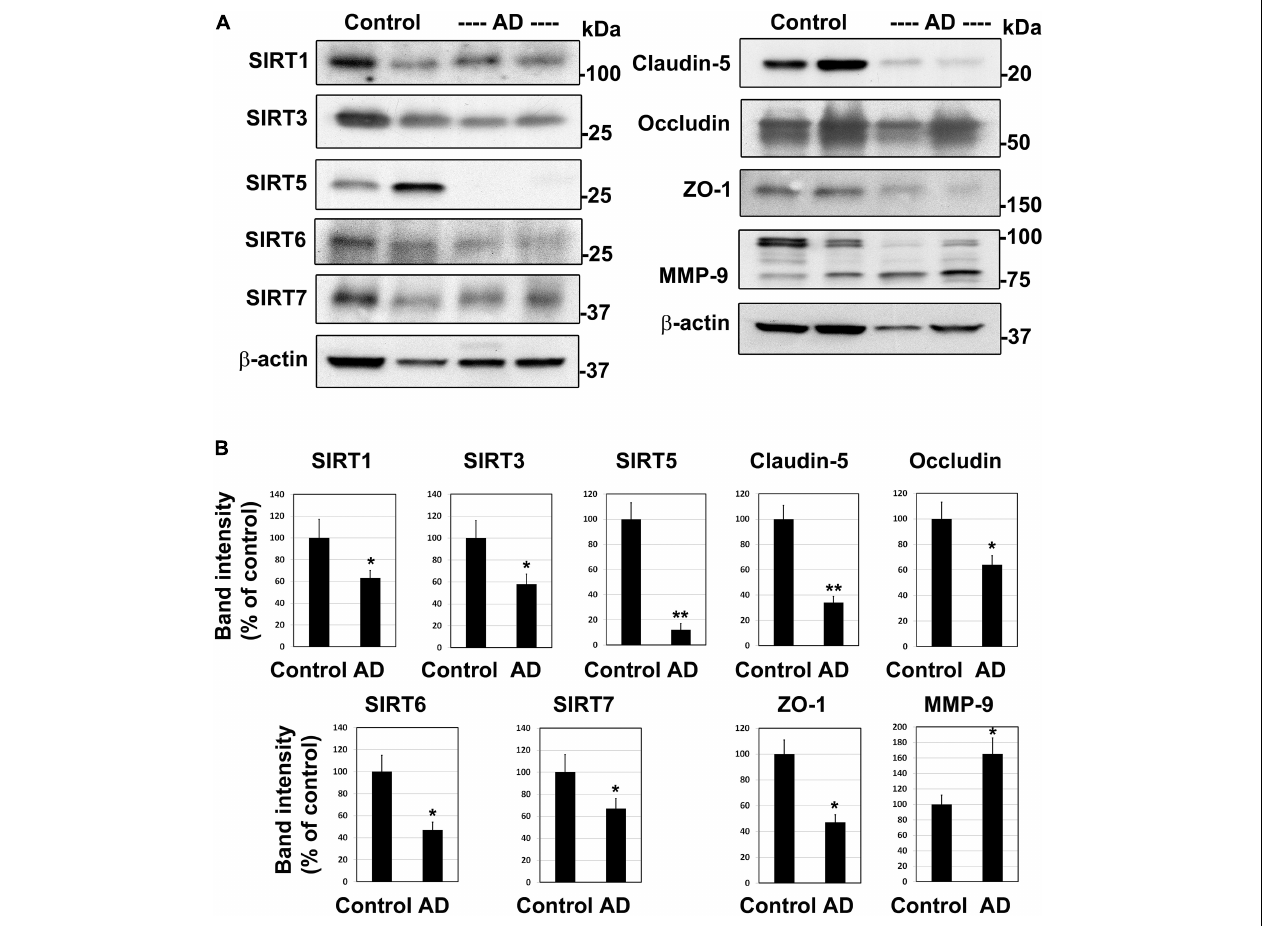
FIGURE 2 | Downregulation of sirtuin pathway and compromised BBB integrity in the human Alzheimer post-mortem brain. (A) Post-mortem brain samples of AD cases and age-matched controls were obtained from Garrison Institute of Aging, Lubbock, TX. Western blot analysis was performed for SIRT1, SIRT3, SIRT5, SIRT6, SIRT7, MMP-9 and tight junction proteins, claudin-5, occludin and ZO-1. The blots were re-probed for β -actin. Representative images of 20 samples are presented. (B) The band intensities were determined by scanning, corrected for the levels of β -actin and expressed as percent of control. *, P < 0.01; **, P < 0.001 vs control. AD, Alzheimer’s